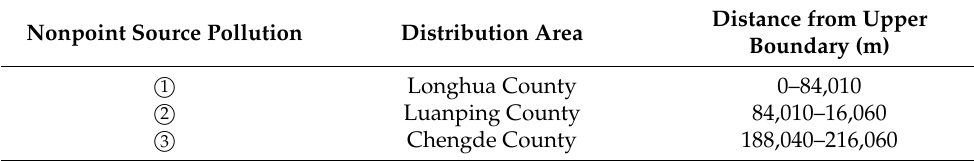
Table 2. Distribution of nonpoint sources flowing into the Luanhe